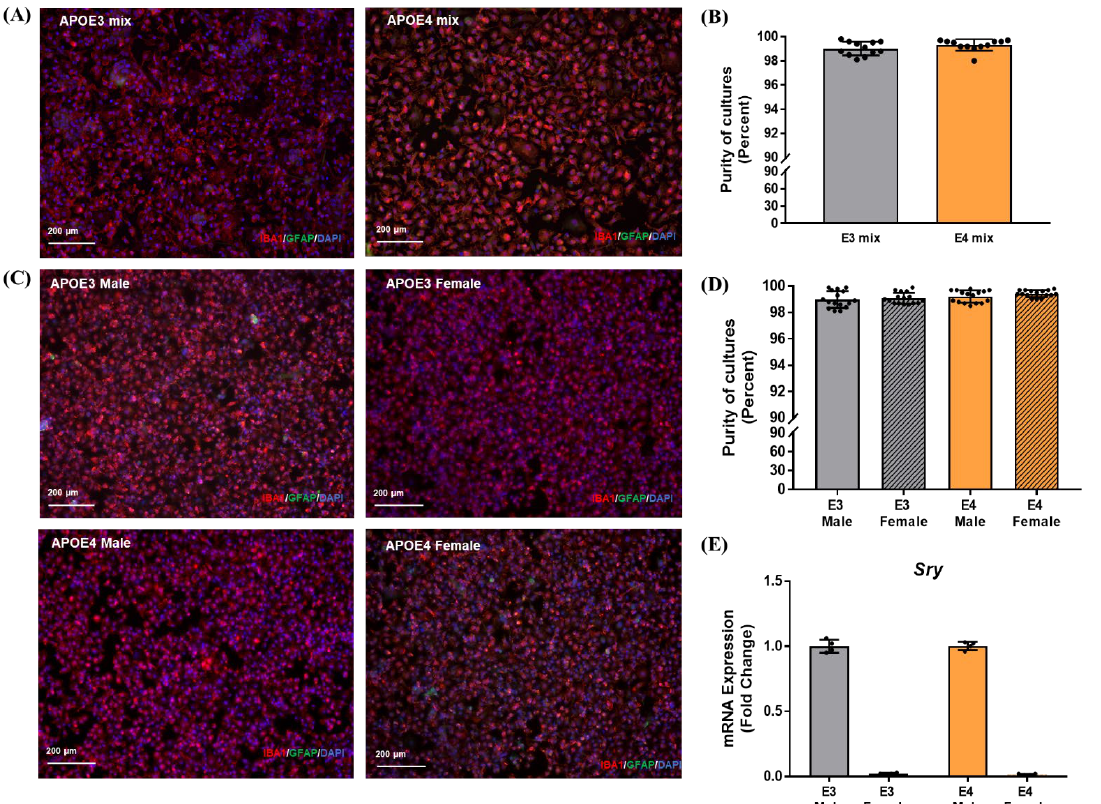
Figure 1. Purity of mixed-sex and sex-specific microglial cultures: ( A ) Representative images for purity of mixed-sex microglial cultures as determined by staining for IBA1 (microglia), GFAP (as- trocyte), and DAPI (nucleus); ( B ) purity of mixed-sex microglial cultures was greater than 98%; ( C ) representative images for purity of sex-specific microglial cultures; ( D ) purity greater than 98% was consistently obtained for all sex-specific microglial cultures. Each data point in ( B , D ) denotes the average percent of microglia from three to four images per well. ( E ) Sex-specificity of cultures was validated by checking for the presence or absence of sex-determining region-Y ( Sry ) by qPCR. Each data point represents the average mRNA expression from one isolation. Data are represented as the mean ± standard